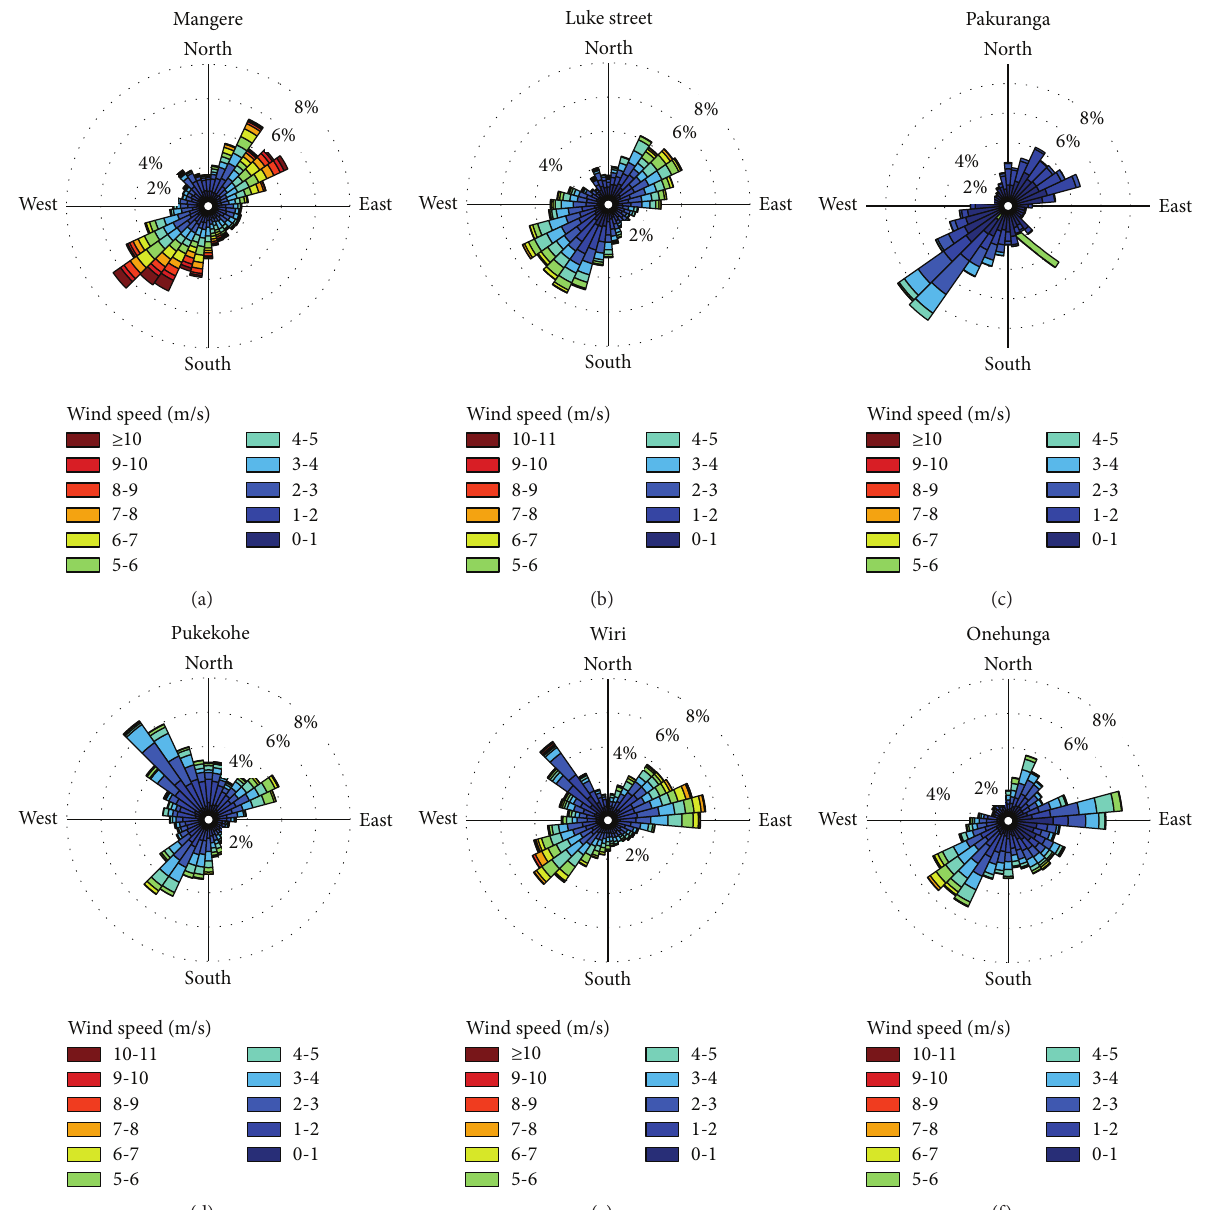
Figure 2: Wind rose diagrams for (a) Mangere, (b) Luke Street, (c) Pakuranga, (d) Pukekohe, (e) Wiri, and (f) Onehunga.